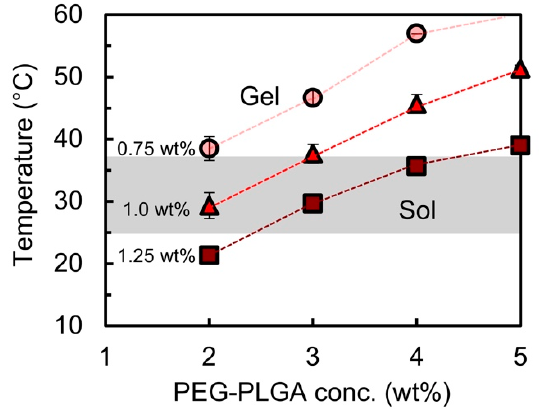
Figure 5. The gelation temperatures T gel of the aqueous laponite/PEG1.0k–PLGA0.8k nanocomposites with different laponite concentrations (0.75 wt %: circles, 1.0 wt %: triangles, 1.25 wt %: squares).